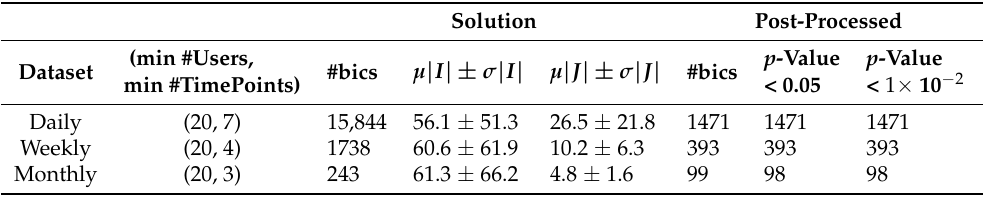
Table 8. Properties of the biclustering solutions found assuming unbounded time lagged patterns at InfraQuinta,